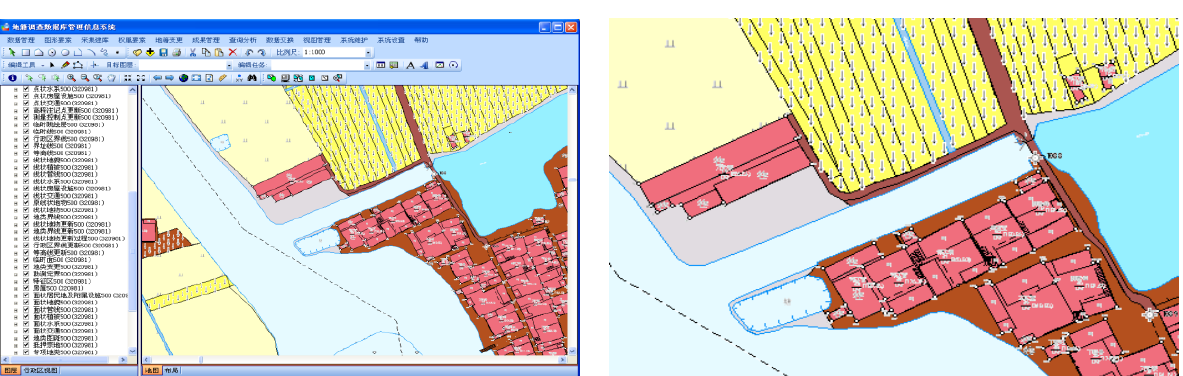
Figure 11. Cadastral change in new model